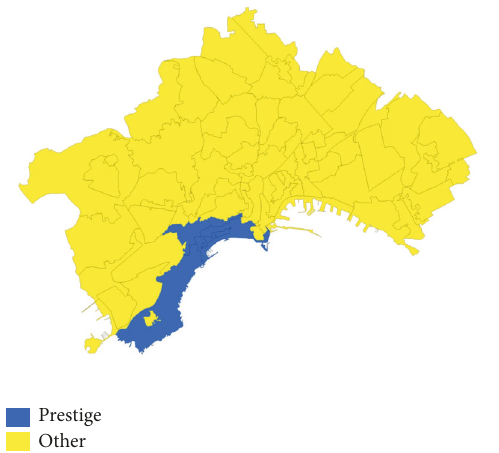
Figure 9: Classification of OMI zones by the variable